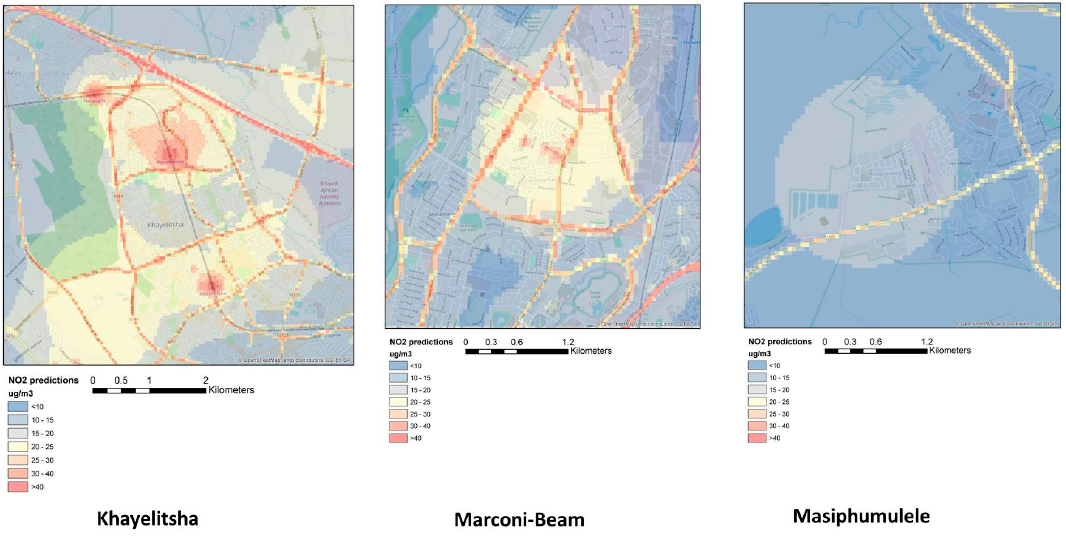
Figure 4. Predictive maps of annual NO 2 levels in all three study areas based on the annual land use regression (LUR) model.